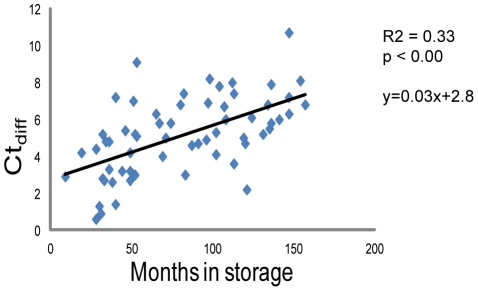
Linear regression analysis.Regression model describing how much of the variation in sample quality (Ctdiff) can be explained by sample storage time prior to extraction.